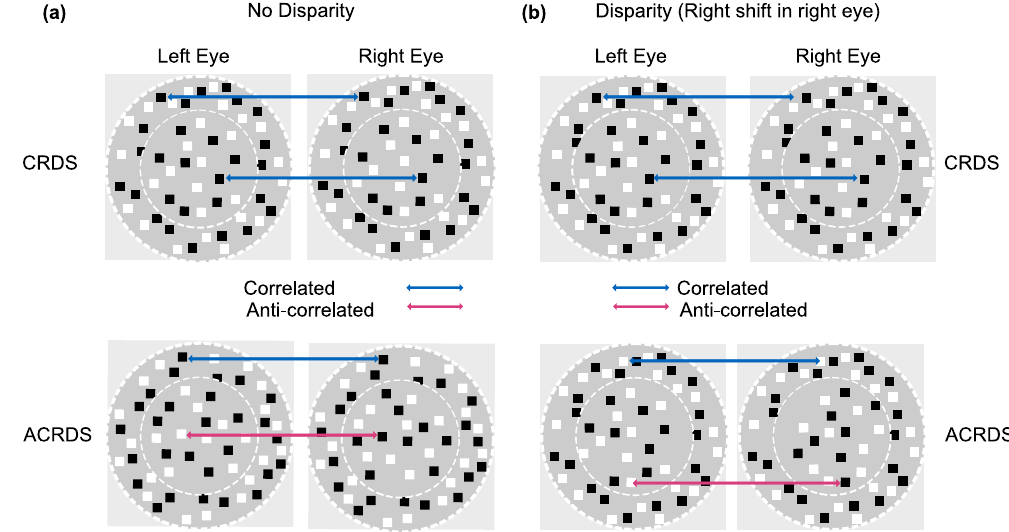
Figure 2. ( a ) Correlated and Anti-correlated RDSs, left image is presented to the left eye and the right to the right eye. Both CRDS and ACRDS have a correlated reference (surround annulus). Correlated RDS (top) have correlated dots in the target (centre circle). In contrast, the central targets in anti-correlated RDS (bottom) have reversed luminance for the corresponding eyes. ( b ) Dots in the target (centre circle) include a rightwards shift for the right eye’s image. The surround for all cases remains correlated with zero